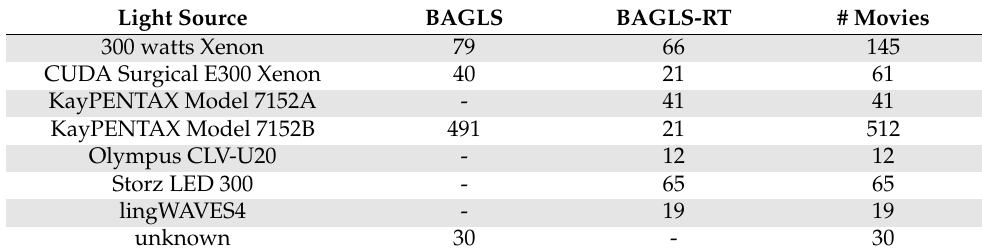
Table A3. Considered light sources.